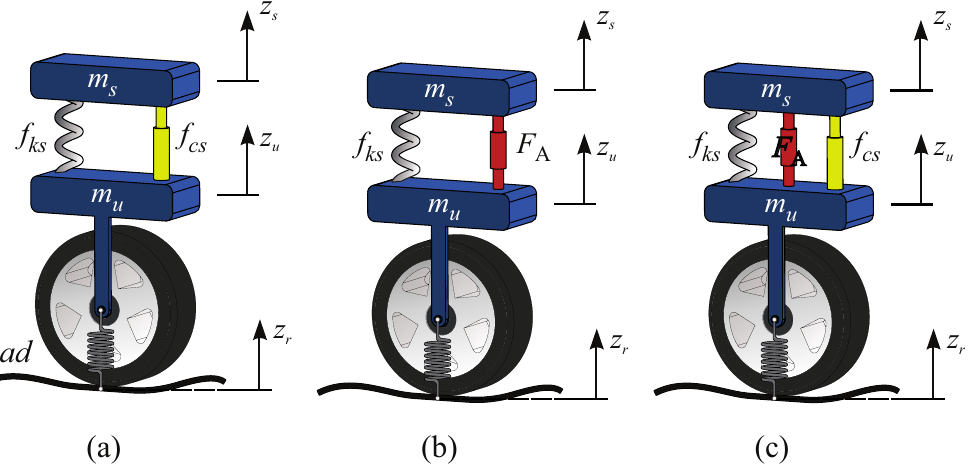
Figure 1. Quarter-vehicle suspension system: ( a ) Passive suspension system. ( b ) Active suspension system with an electromagnetic actuator. ( c ) Active suspension system with a hydraulic